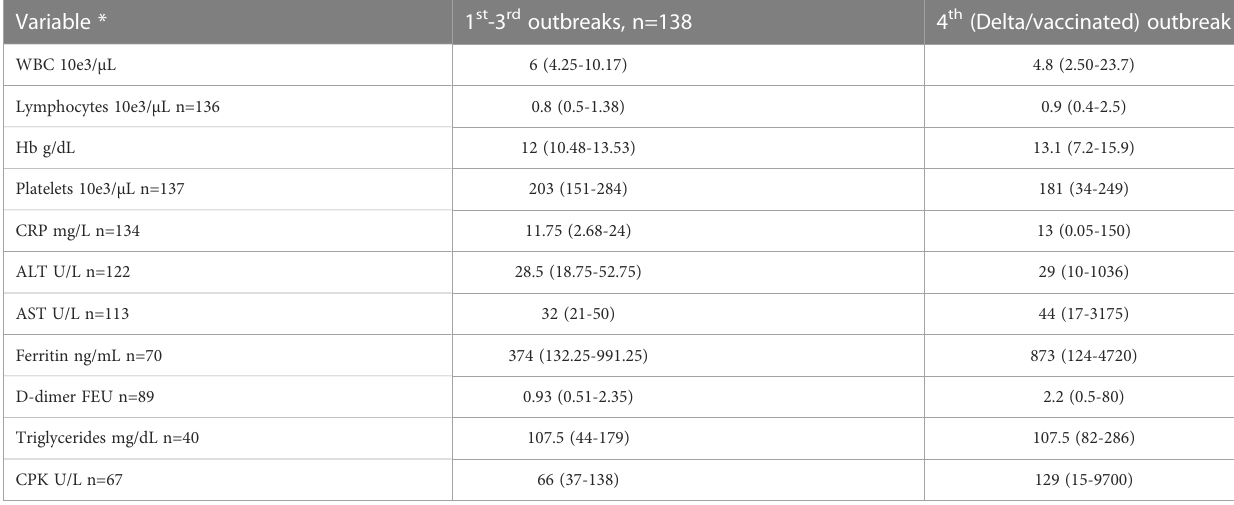
TABLE 3 Laboratory tests of AIIRD patients hospitalized for COVID-19. Variable